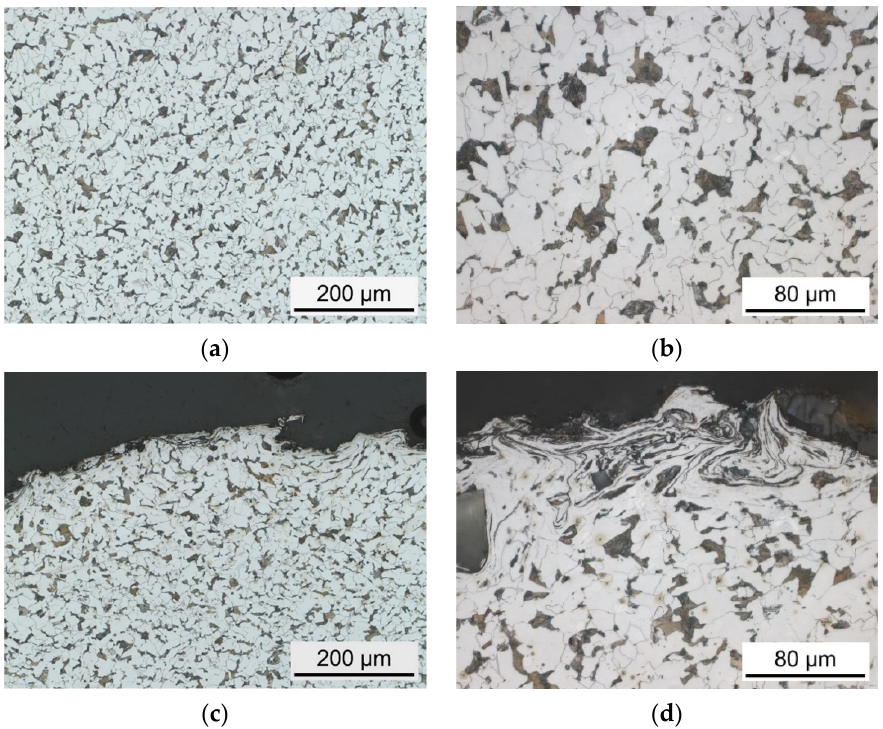
Figure 7. Polished cross-section of sandblasted (I) specimen; etched with 5% Nital solution, ( a , b ) microstructure of center area, ( c , d ) microstructure of edge area.